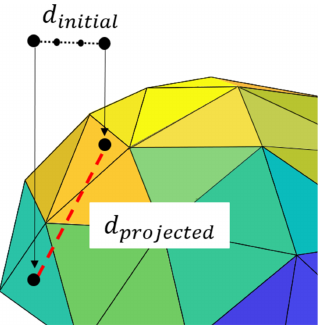
Figure 5. The initial distance between two points might be different after projection: d initial (cid:54) = d projected